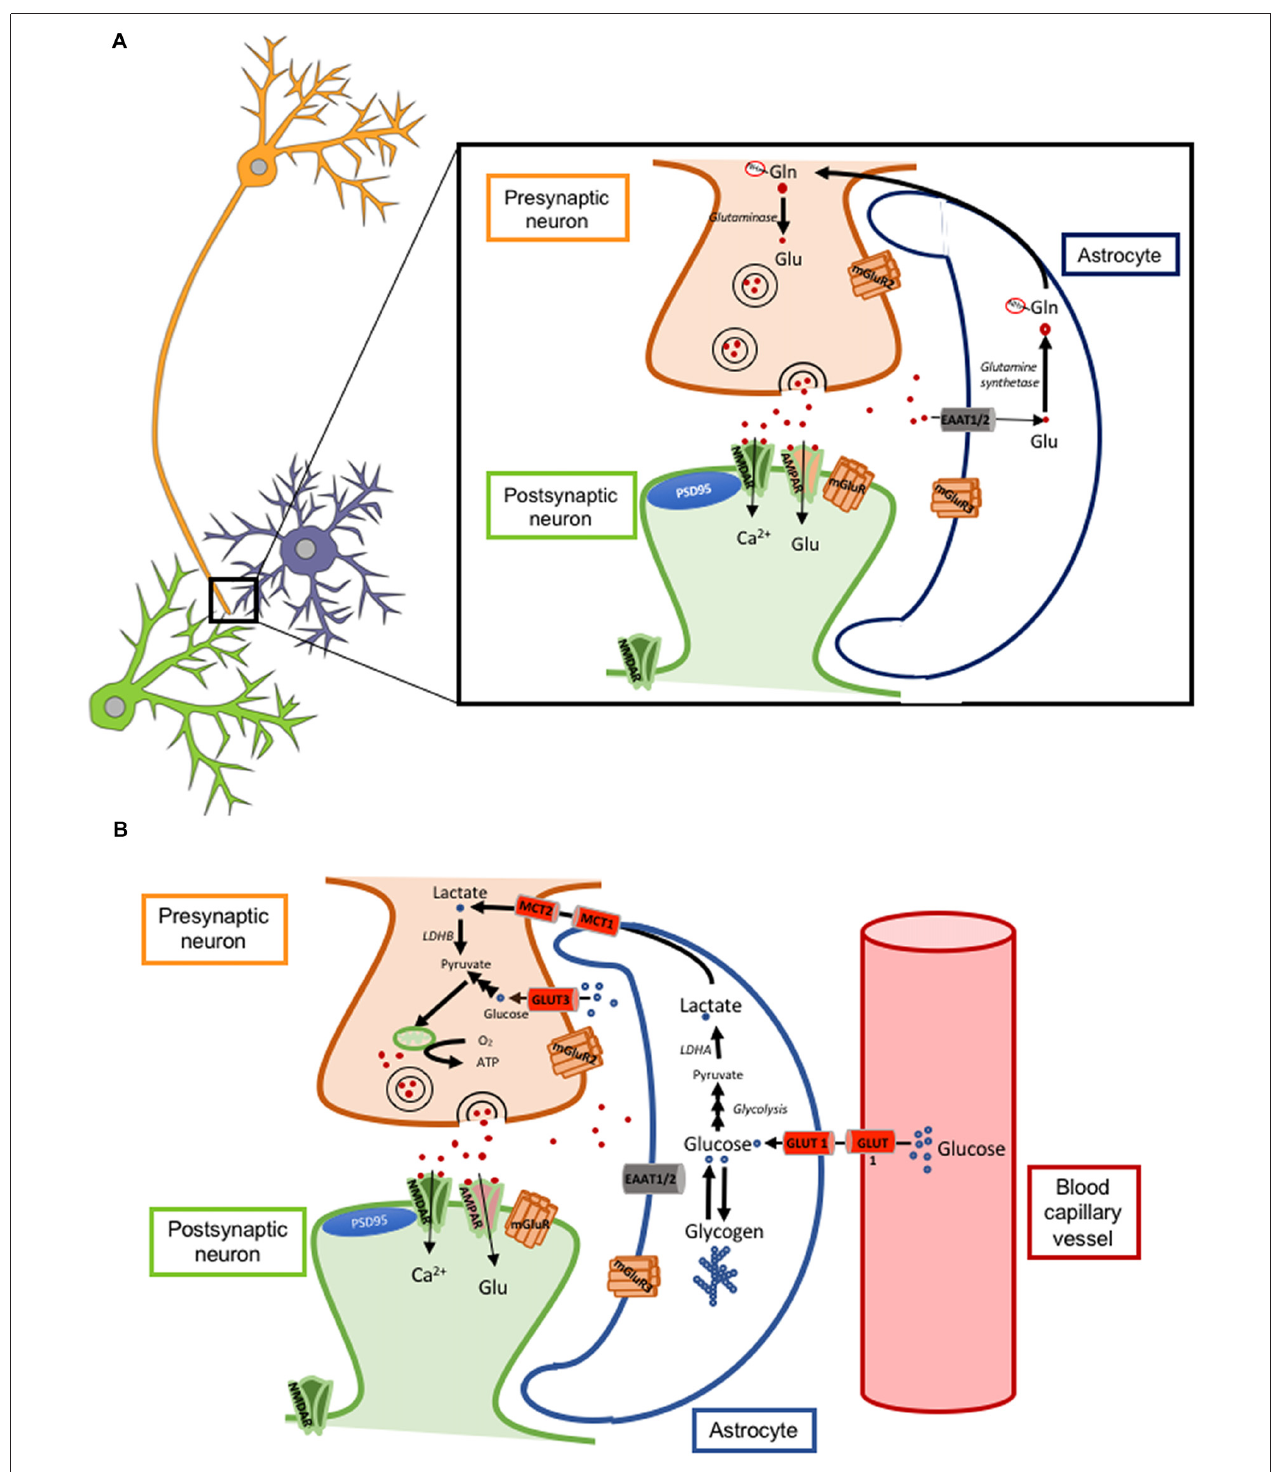
FIGURE 2 | Astrocyte-neuron glutamate-glutamine cycle and lactate shuttle. (A) Cartoon illustrating a tripartite excitatory synapse with the glutamate-glutamine cycle. (B) Cartoon illustrating a tripartite excitatory synapse and a glioneurovascular unit with the lactate shuttle. Abbreviations: AMPAR, α -amino-3-hydroxy-5-methyl-4-isoxazolepropionic acid receptor; ATP, adenosine triphosphate; EAAT, excitatory amino acid transporter; Gln-NH3, glutamine; Glu, glutamate; GLUT, glucose transporter; LDH, lactate dehydrogenase; MCT, monocarboxylate transporter; mGluR, metabotropic glutamate receptor; NMDAR, N-methyl-D-aspartate receptor.